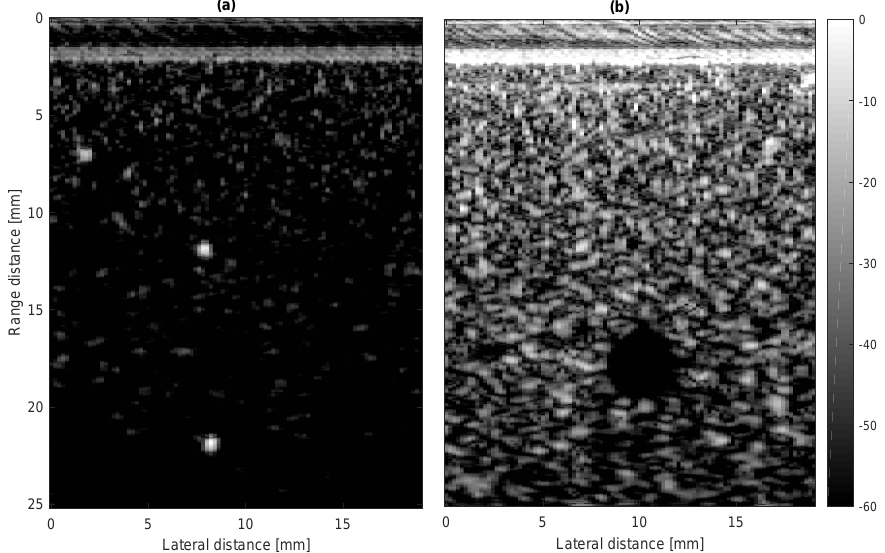
Figure 6. B-mode images of ( a ) wire phantom and ( b ) cyst phantom obtained by mAPES beamformer with gPCF estimated in a conventional way, i.e., gPCF was estimated without sub-aperture beamforming. Element echo signals before application of mAPES beamformer weights were used for estimation of